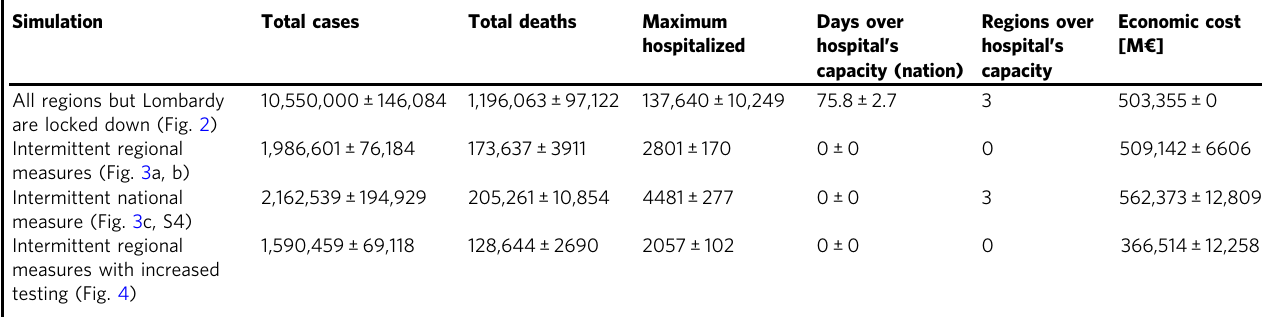
Table 2 Comparison of each of the simulated